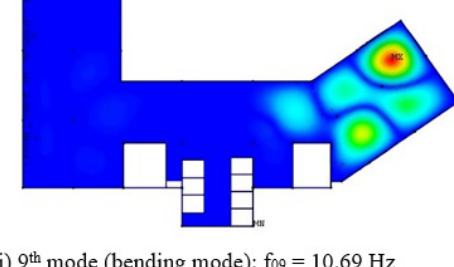
Figure 10. Vertical bending vibration modes of the floors under